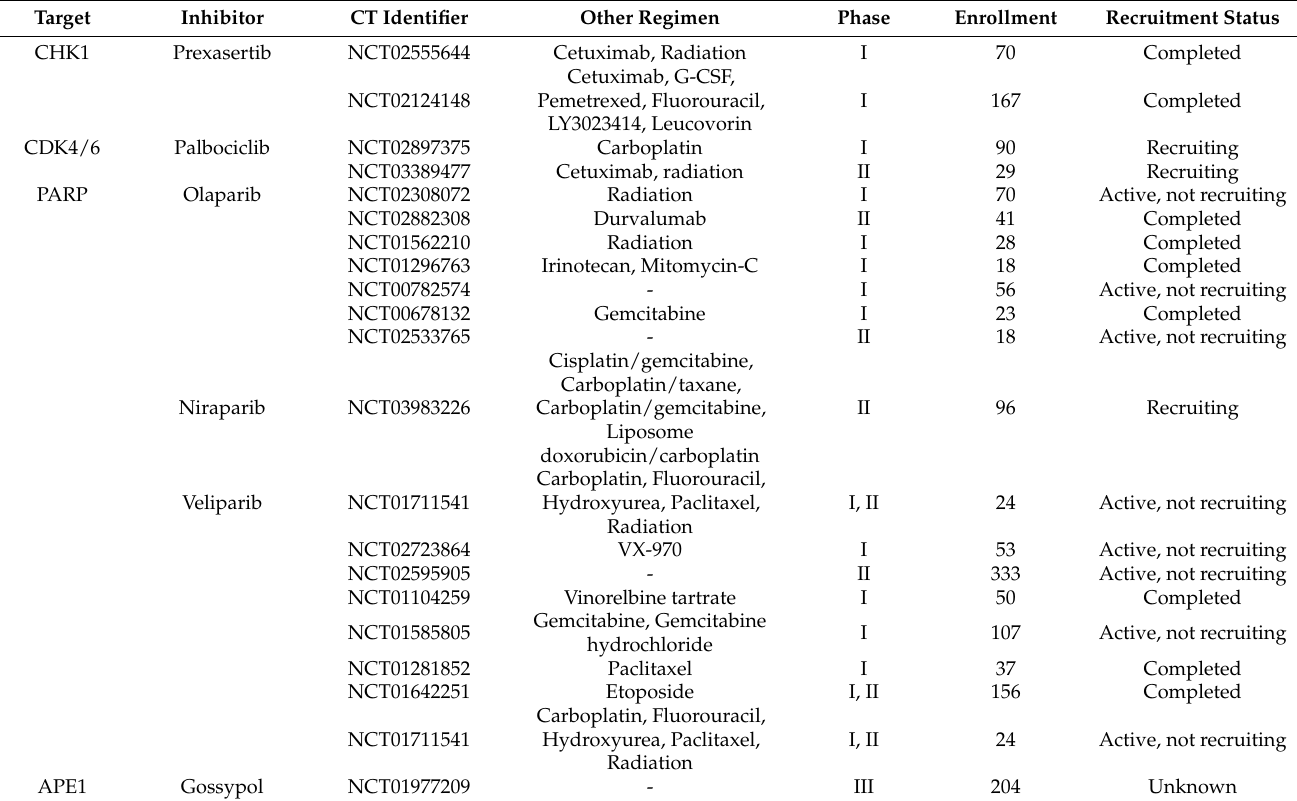
Table 1. Clinical trials studying combination chemotherapy of inhibitors with